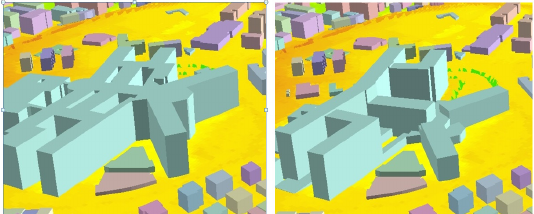
Figure 3 Comparison between 3D models (at LoD1) of the same building, obtained from a single footprint (left) and from multiple sub-footprints.